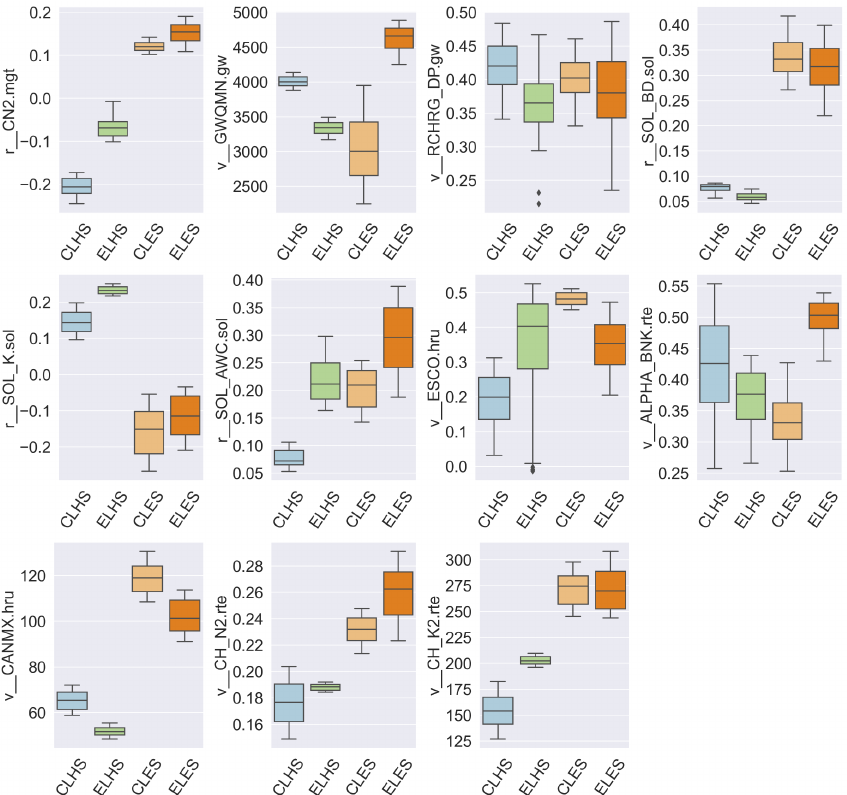
Figure A4. Boxplots of parameter range distribution of top 5% performing simulations during initial validation. The parameter descriptions and units are listed in Table 3.